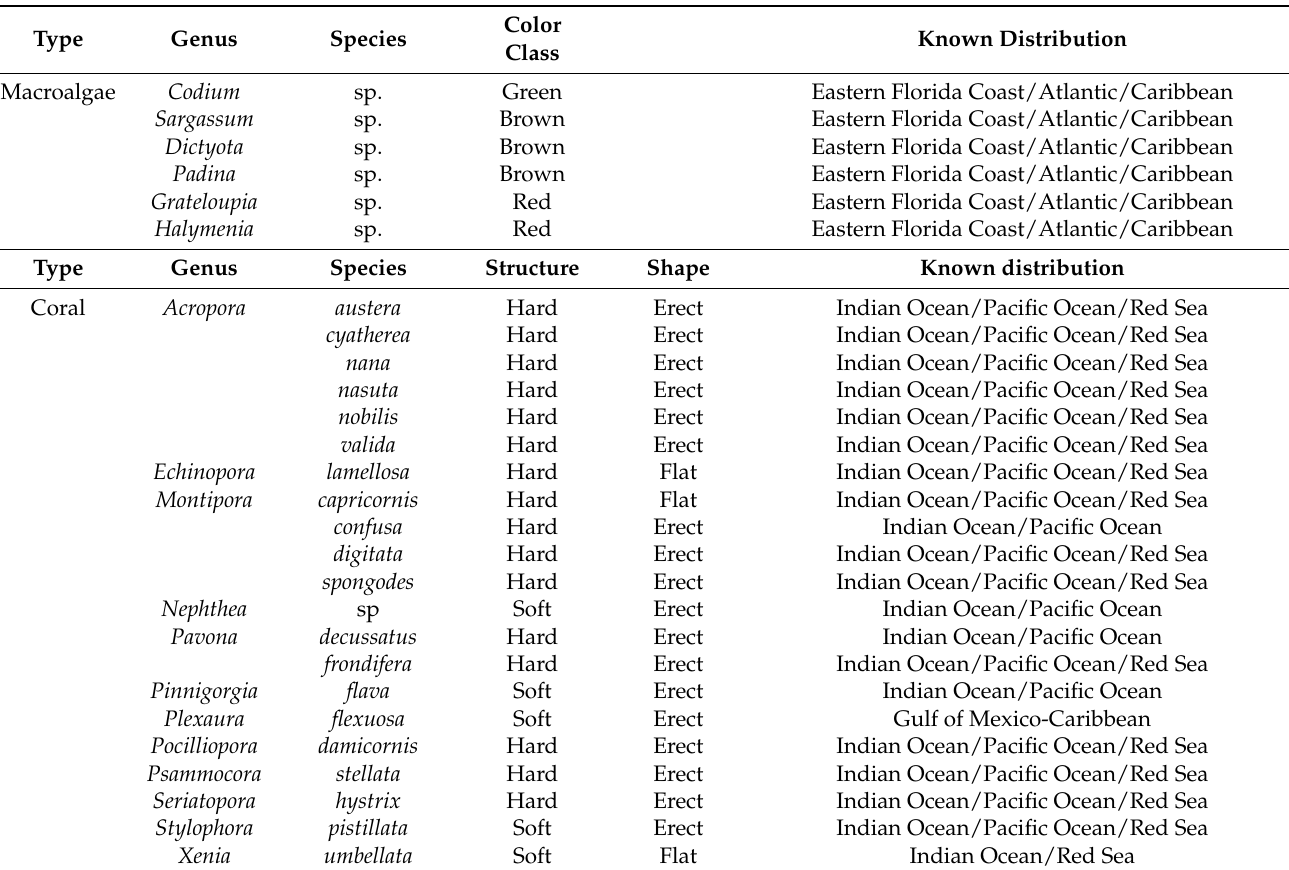
Table A1. Macroalgal and coral genus, species, and group names used during imaging trials (distri- bution obtained from the World Register of Marine Species database